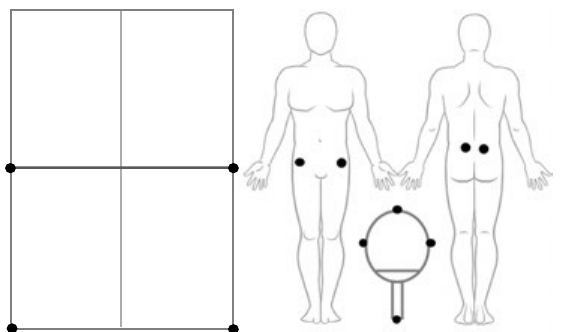
Figure 4. Reflective marker placement on subject,